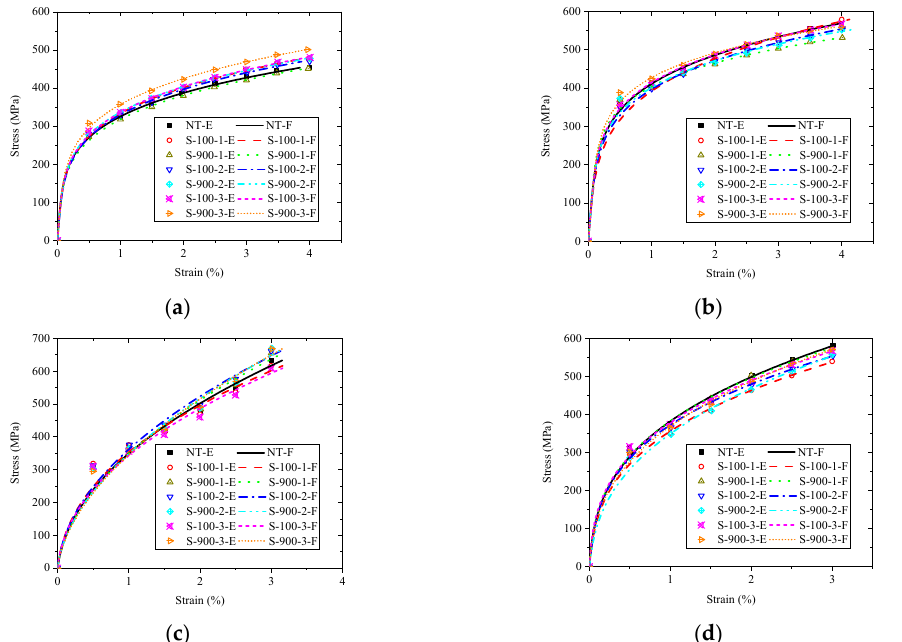
Figure 21. Comparison of experimental and fitting skeleton curves. ( a ) Q235; ( b ) Q345; ( c ) S304; ( d ) S316.